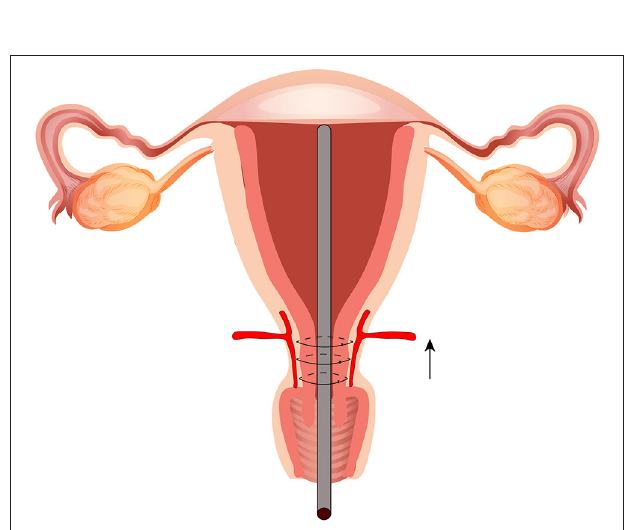
FIGURE 1 | (A–C) Patient No.16 of study group: marginal placenta previa. The placenta invaded the serous layer of the uterus and the posterior wall of the bladder, and the adjacent areas showed rich blood flow signals. (D–F) Patient No.23 of study group: complete placenta previa. The placenta invaded the serous layer of the uterus, and the adjacent areas showed rich blood flow signals.